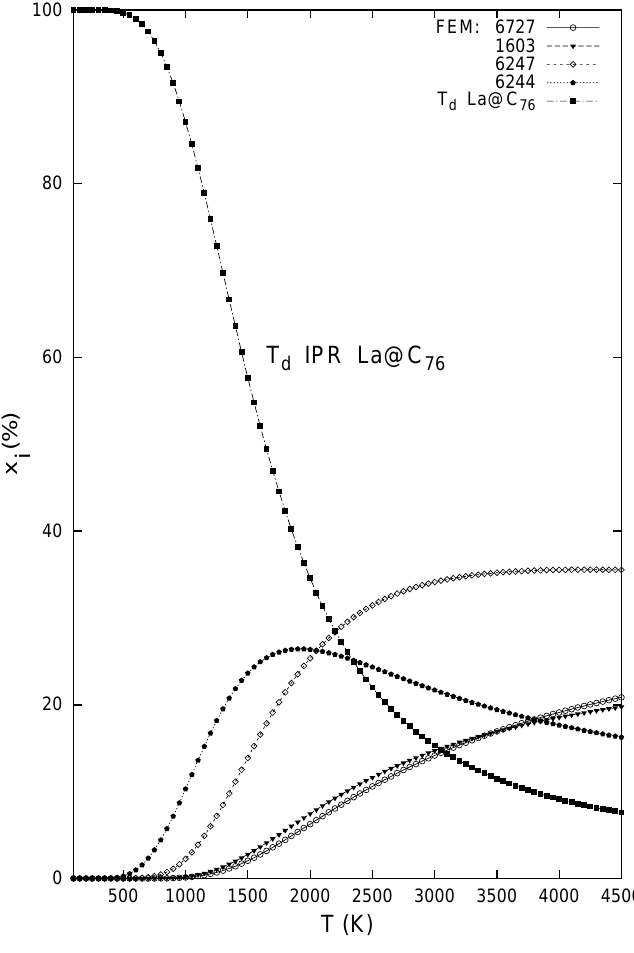
isomers computed with 76